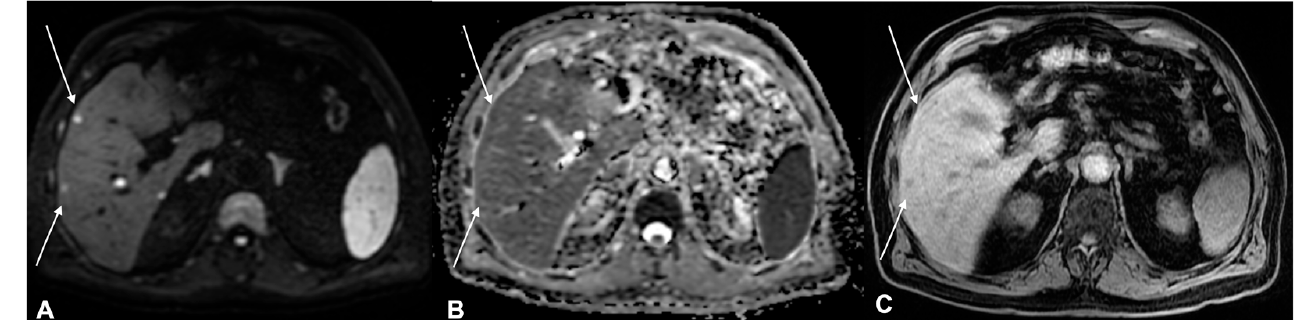
Figure 11. MRI examination of the previous patient performed in August 2021. DWI ( A ), ADC ( B ), enhanced MRI imaging ( C ). The lesions show high signal in DWI, low signal in ADC, and intensity reinforcement in the contrast-enhanced study image. Suspicious areas are confirmed as metastatic lesions.